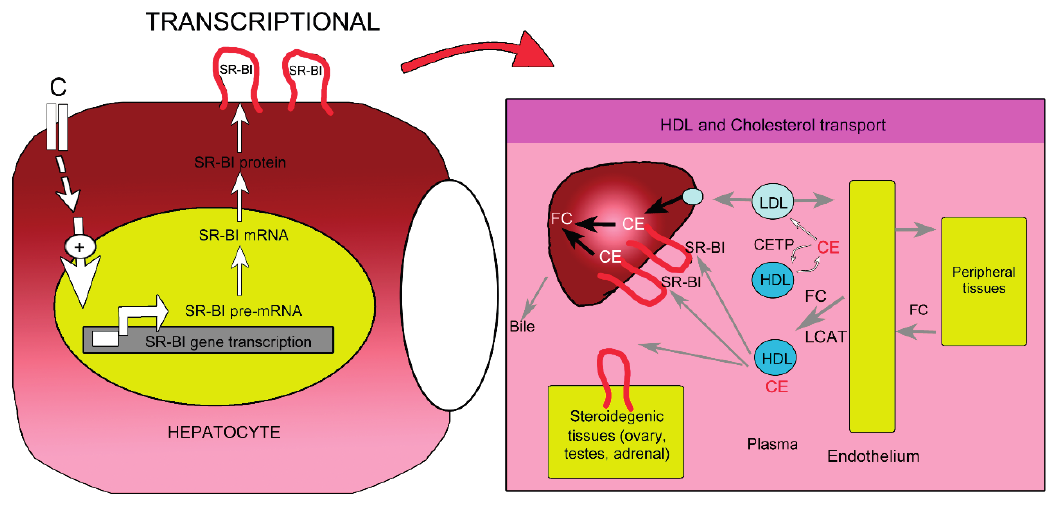
Figure 6. Proposed mechanism for hypocholesterolemia activity of compounds C from P. macrocarpa leaves through the enhancement of SR-BI gene expression at the transcription level (modified from Leiva et al. [49] and Krieger